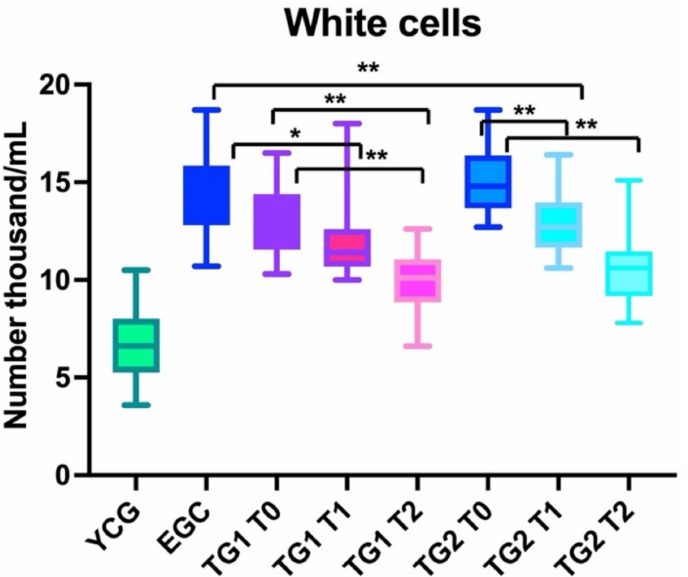
Figure 2. The box graph shows the differences in term of lymphocytes number between young control group (YCG), elderly control group (ECG), treatment group 1 (TG1), and treatment group 2 (TG2); for TG1 and TG2, T1 and T2 were also described. YCG and ECG were always statistically significant different from TG1 and TG2 at T1 and T2. ** p < 0.01 * p